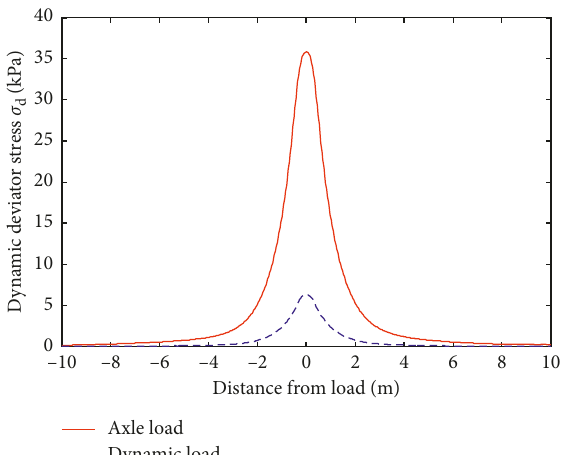
Figure 6: Distributions of cumulative plastic strain ε d at the million